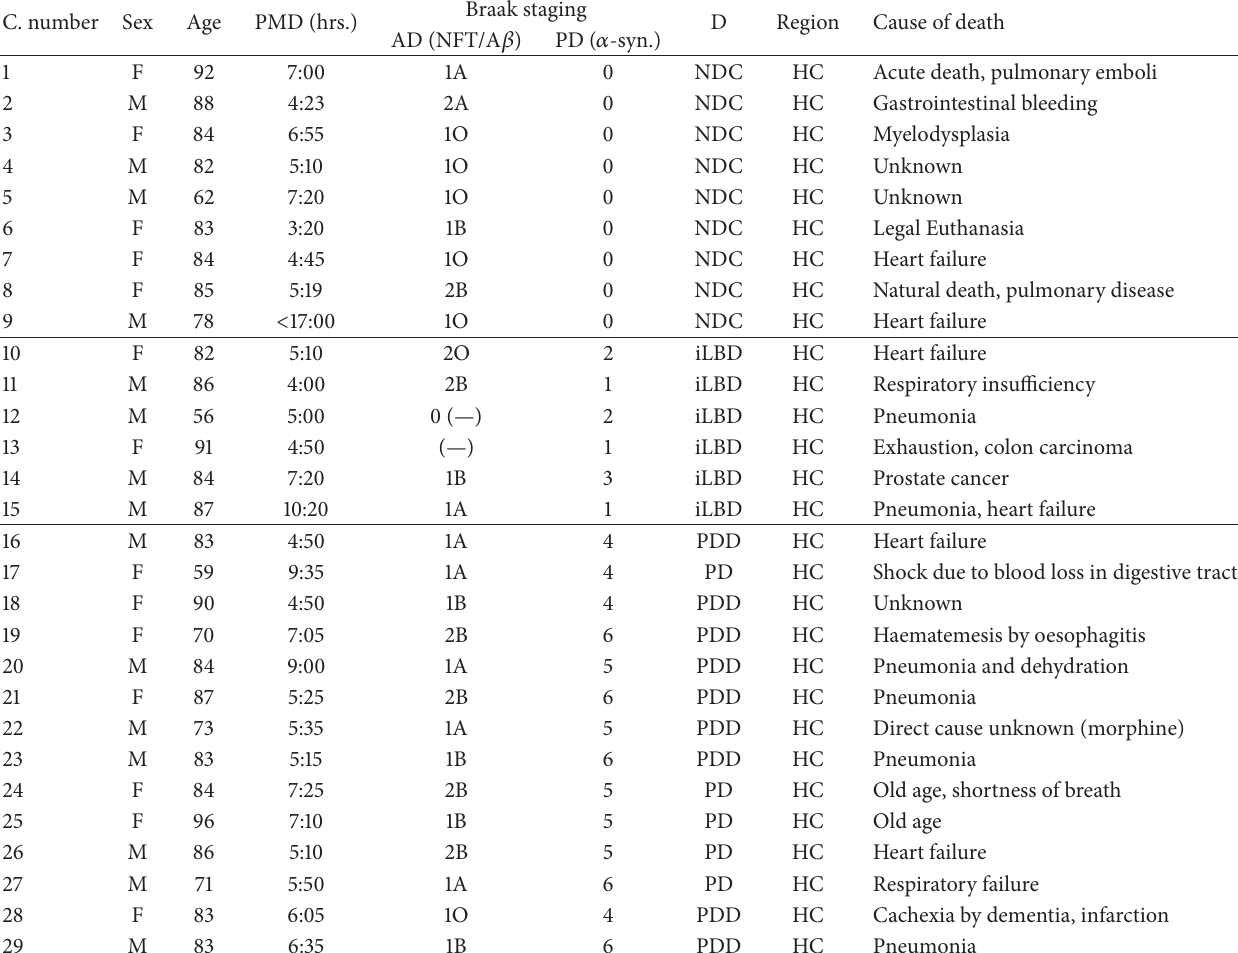
Table 1: Clinical and neuropathological information of all included